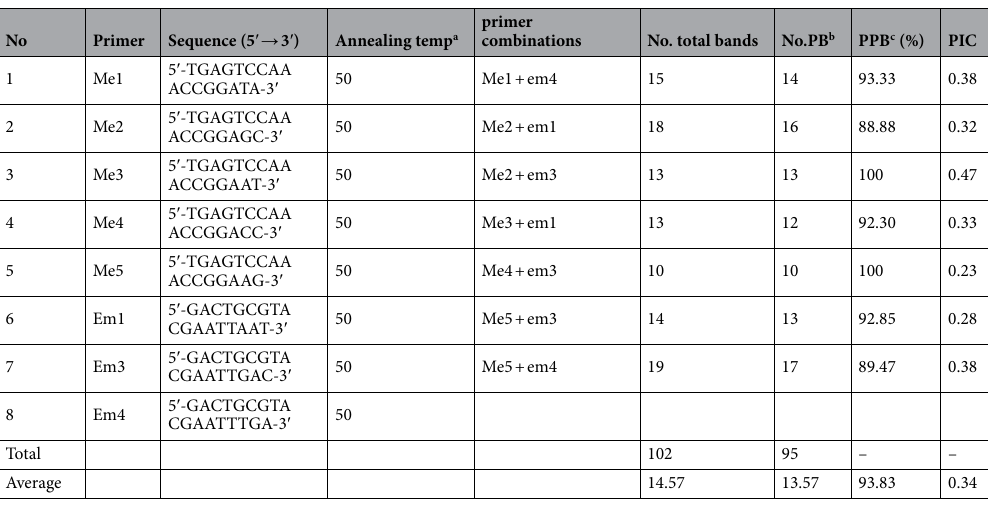
Table 5. Polymorphism number, annealing temperature and PIC of studied Thymus species. a Degrees celsius (°C). b Number of polymorphic band. c Percentage of polymorphic